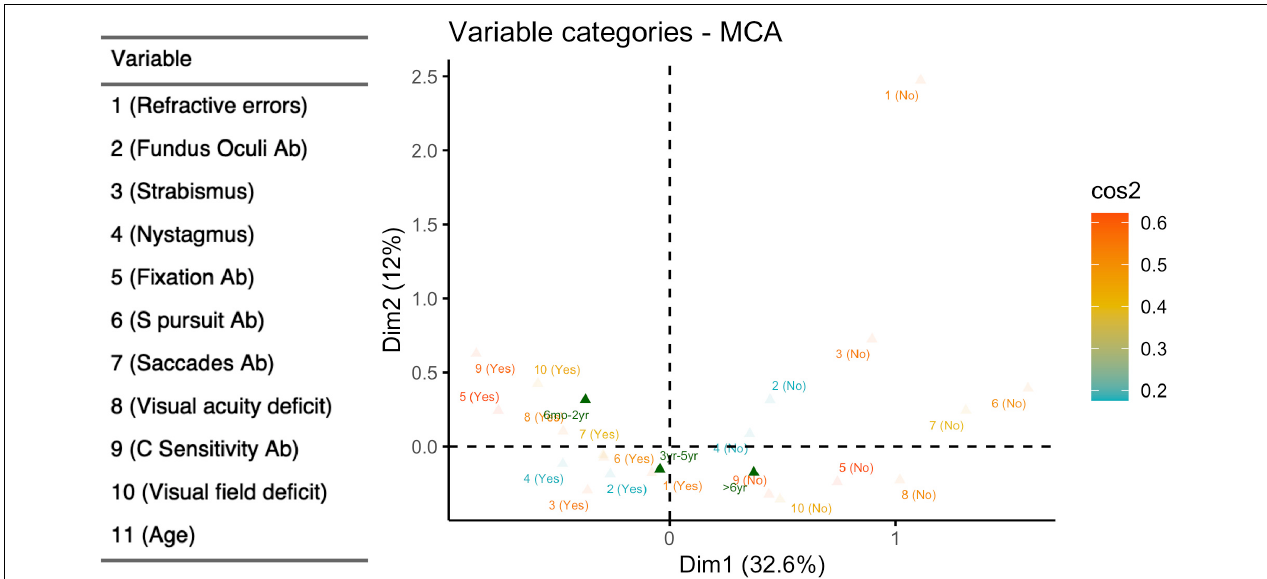
FIGURE 7 | Multiple correspondence analyses (dichotomized items). Coordinate plot: MCA of 10 visual items after dichotomization; supplementary variables: age subgroup, defined as 6 months-2 years, 3–5 years, > 6 years. Explained variability: 1st dimension (horizontal axis) 32.6%; 2nd dimension (vertical axis) 11.9%. Yes (presence of visual deficit); No (absence of visual deficit); Ab